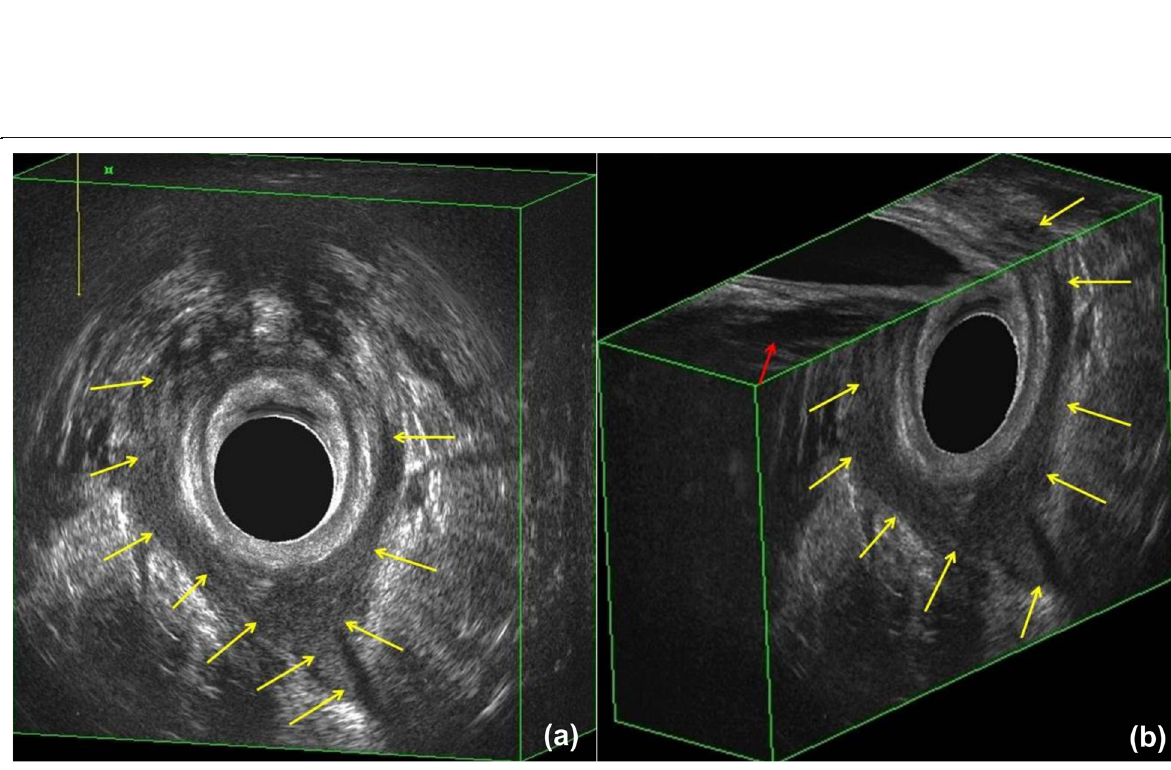
Fig. 10 3D TRUS image of transsphincteric fistula with secondary extensions into bilateral intersphincteric plane (hypoechoic area marked by yellow arrows) at the upper anal canal level. a Axial view. b Section showing the involvement of the right levator plate with edema (red